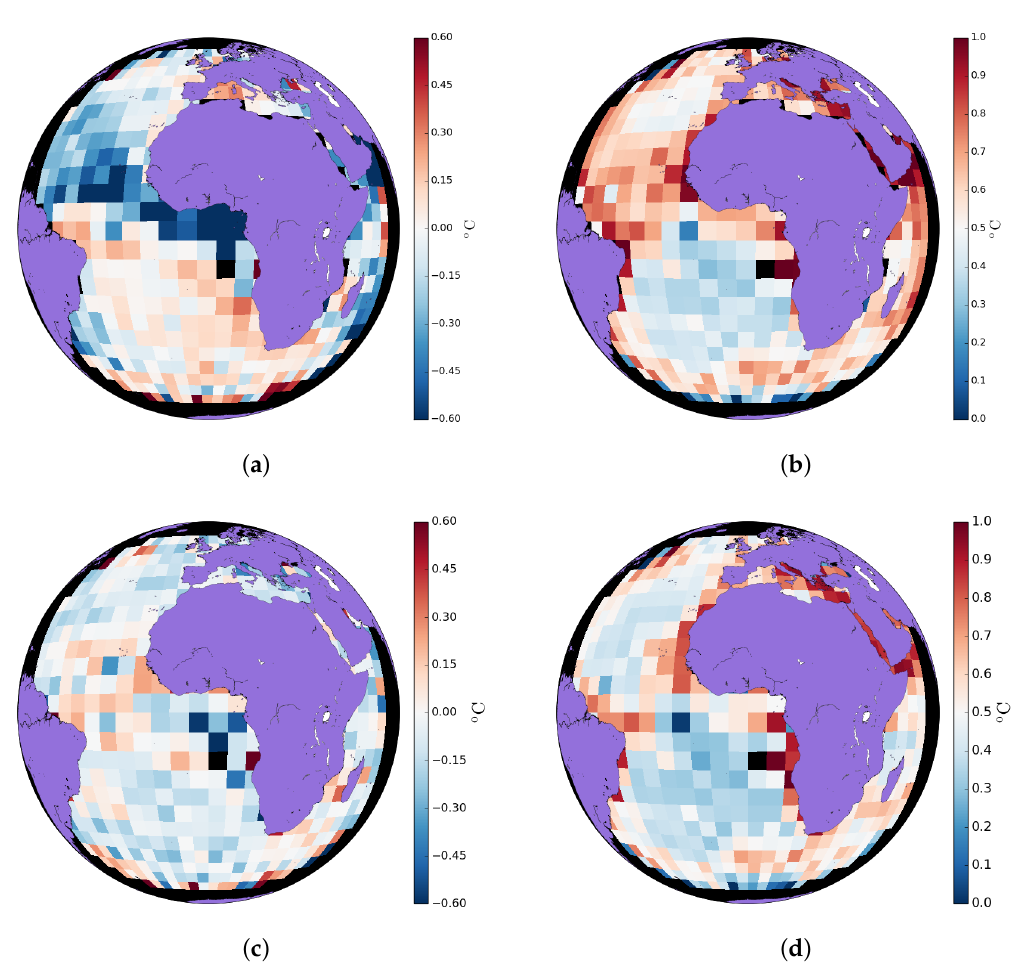
Figure 5. ( a ) Mean and ( b ) standard deviation of SST sat − SST buoys on test sample; ( c ) Mean and ( d ) standard deviation of SST corr − SST buoys with correction by random forest model on test sample. Large scale features in the predicted error can be visually correlated to atmospheric